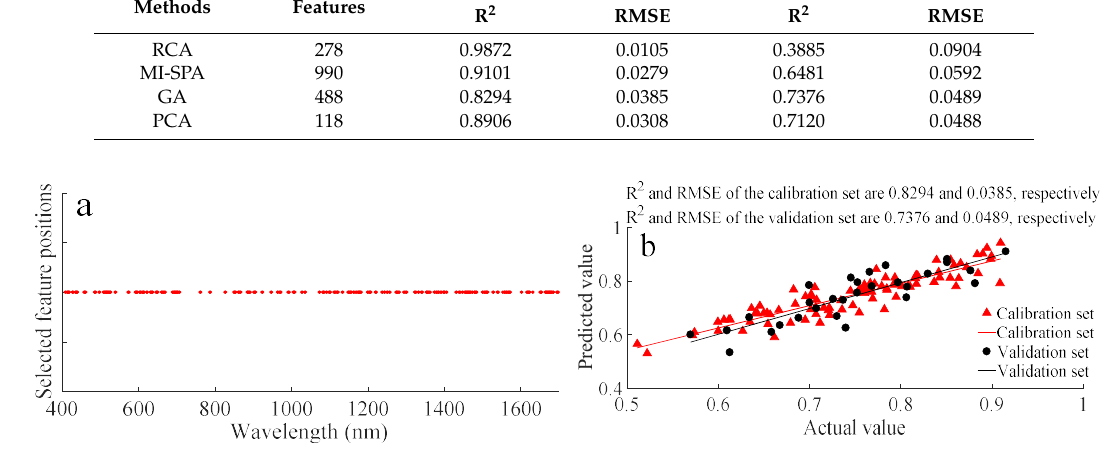
Figure 5. Pomelo water content PLSR detection based on SG + MSC data processing and GA feature selection: ( a ) corresponding wavelengths of selected features and ( b ) PLSR detection result based on SG + MSC + GA processed data.